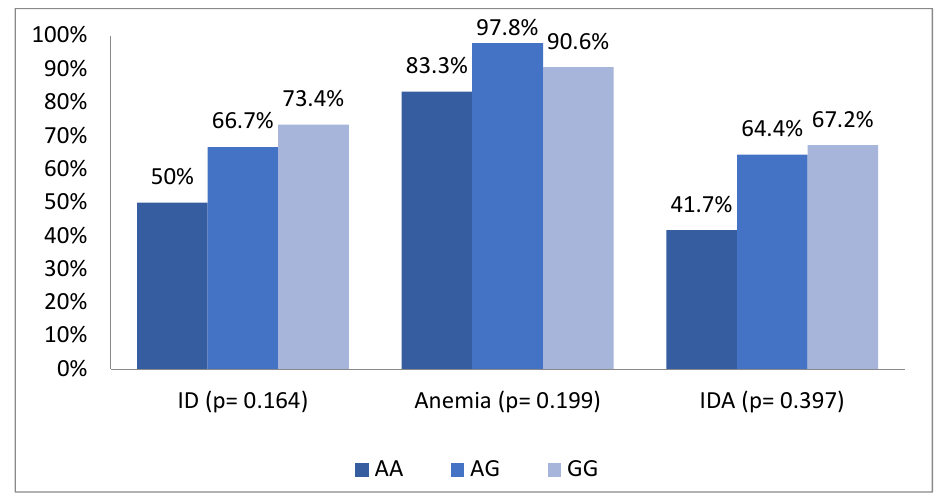
Figure 1. Distribution of Iron deficiency, anemia and iron deficiency anemia status across genotypes of SNPs